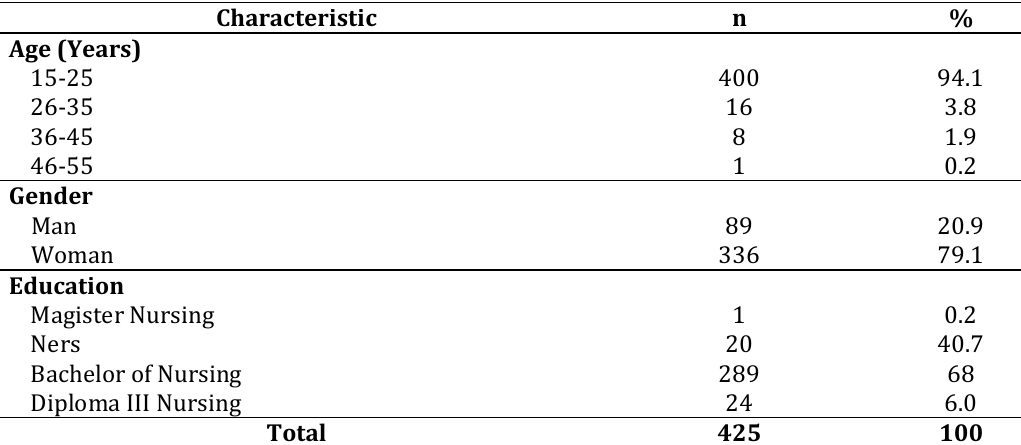
Characteristics student of nursing in Bali